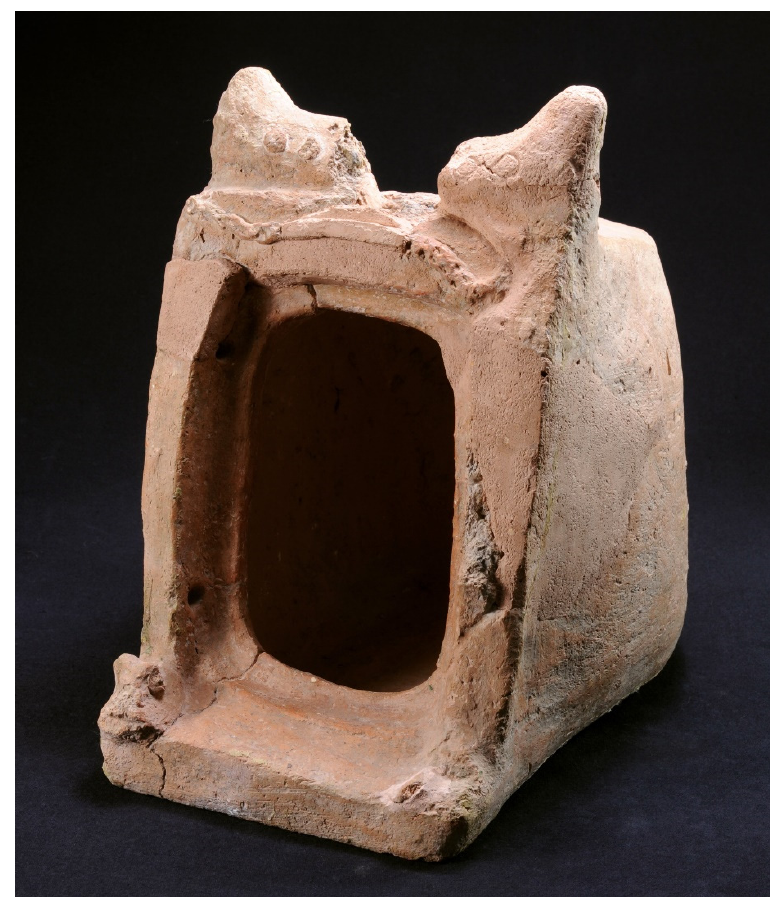
Figure 14. Pottery shrine model from Tel Rekhesh, northern Israel, 9th–8th centuries BCE (courtesy of the Israel Antiquities Authority). Religions 2019 , 10 , x FOR PEER REVIEW